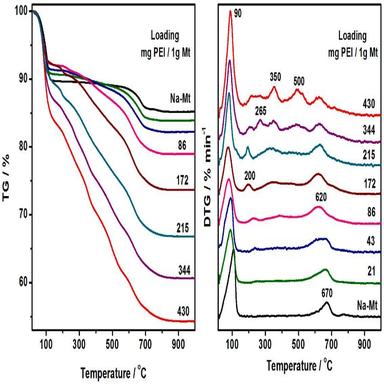
TG and DTG curves of PEI-Mt prepared with different initial amounts of PEI, indicated in the figure.